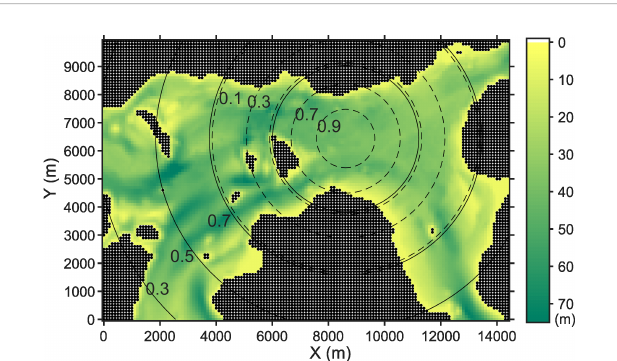
FIGURE 2 Domain of a numerical ocean model used in this study. The color indicates the water depth, and black dots correspond to land grids. The boundaries without dots (i.e., not land) are open boundaries where prescribed tidal forcing is given to drive the fl ow in the model domain. The dashed and solid circles are contours of the two covariance localization radii (4 km and 10 km) with a contour interval of